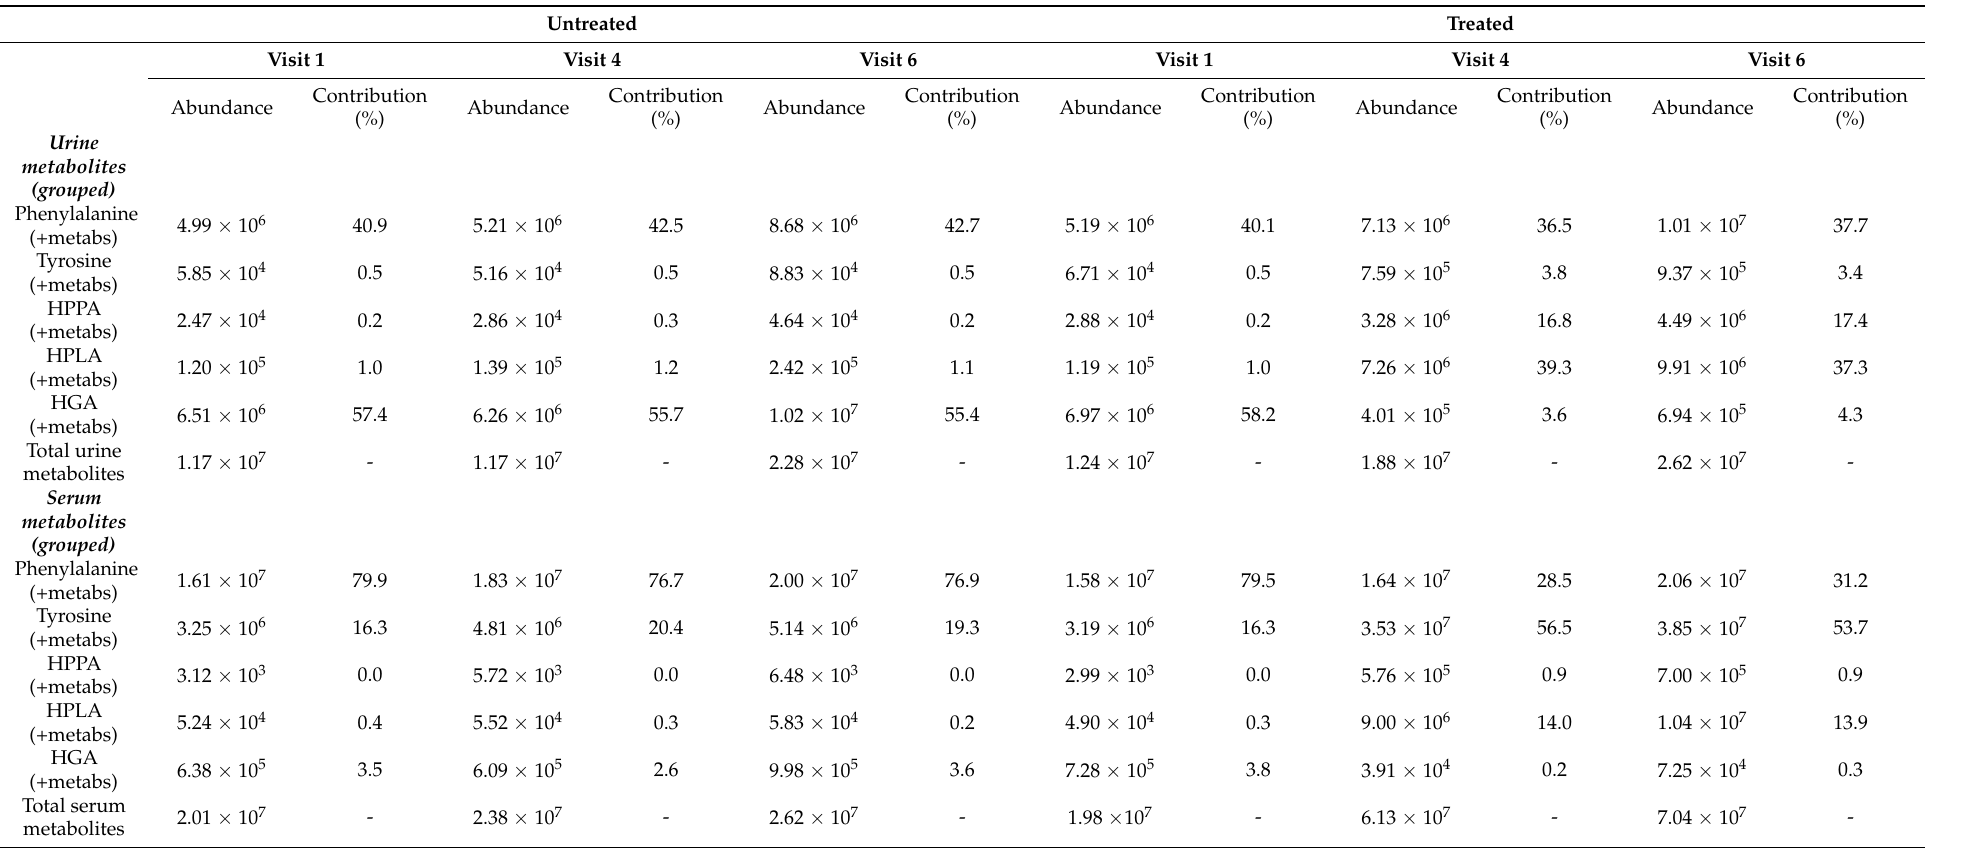
Table 4. Mean cumulative peak area abundance of metabolites in urine (24 h creatinine normalised only) and serum (raw non-normalised) across treatment groups and visits grouped according to respective phe-tyr precursor metabolites (phenylalanine, tyrosine, HPPA, HPLA and HGA). Visits 1, 4 and 6 refer to baseline, 24 and 48 months, respectively. Patients in the treated group were on nitisinone at visits 4 and 6. For individual contributions of all metabolites see Table S1. ‘Metabs’: